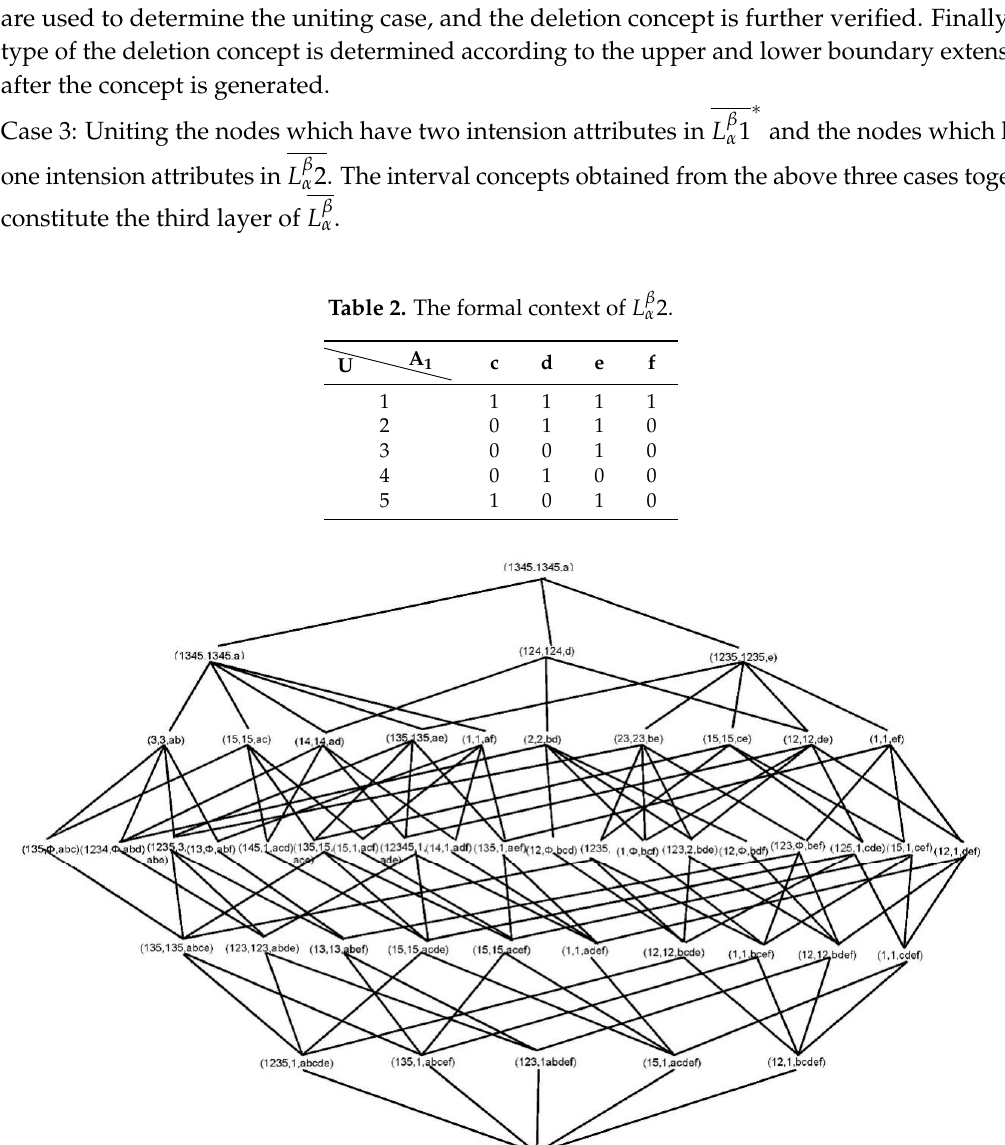
Figure 2. The lattice structure L β α ( U , A , R ) united by L β α ( U , A 1 , R 1 ) and L β α ( U , A 2 , R 2 ) for the Interval parameters α = 0.6 and β =